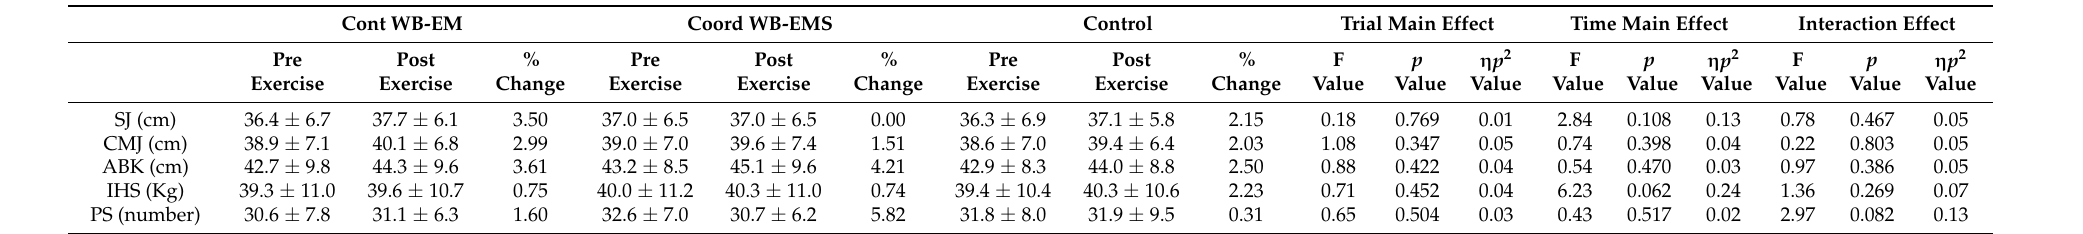
Table 2. Changes (Mean ± SD) in the squat jump (SJ), countermovement jump (CMJ) and Abalakov jump (ABK) tests, isometric handgrip strength (IHS), and punching speed (PS) after the strength exercise session with the continuous stimulus (Cont WB-EM), coordinated stimulus with concentric and eccentric phases (Coord WB-EMS) and without whole-body electromyostimulation